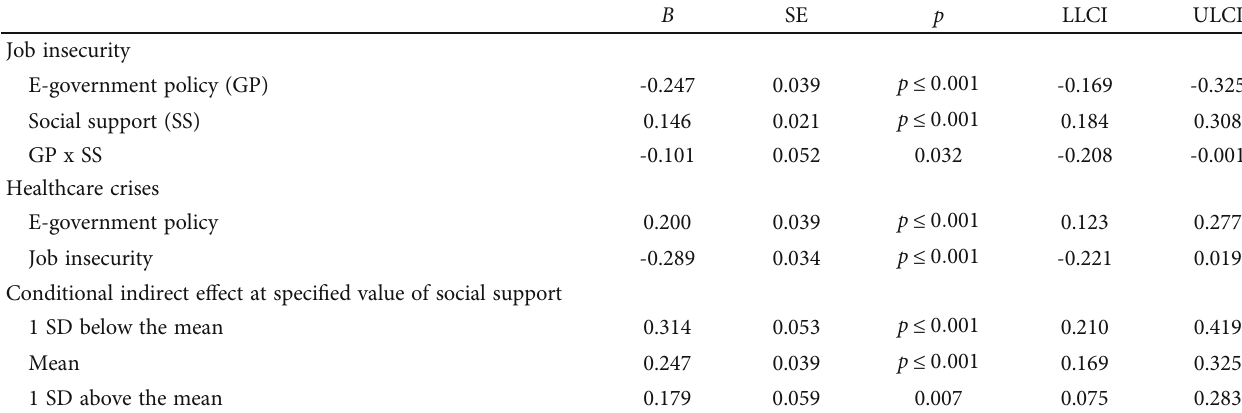
Table 6: Regression results for conditional process analysis ( N = 435 ).